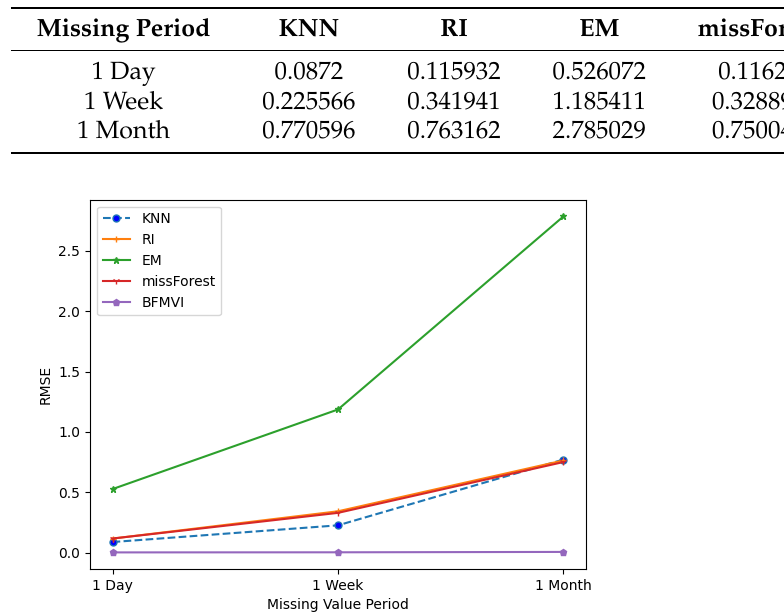
Figure 3. Comparison of Imputation Techniques on C 6 H 6 Missing Values occurring over Consecutive